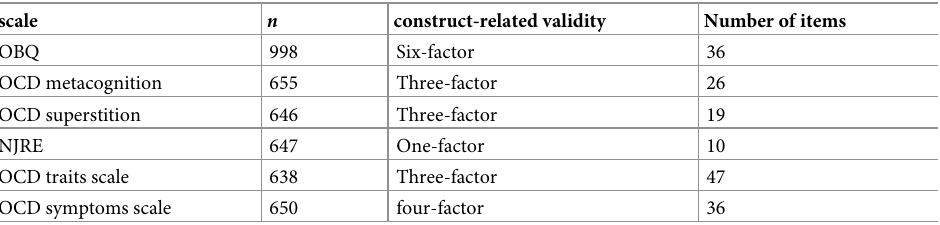
Table 4. Results of the six scales’ analysis of construct-related